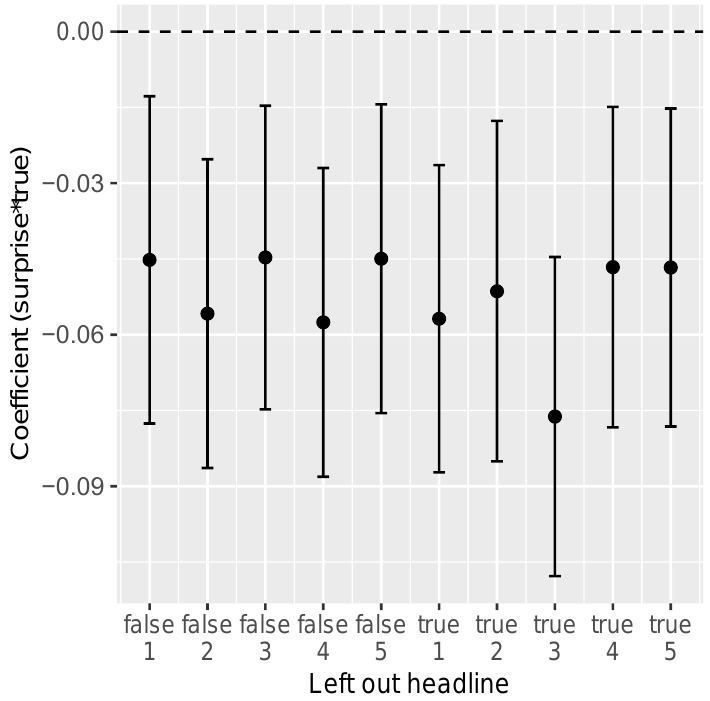
Figure C3. Leave one out analysis –